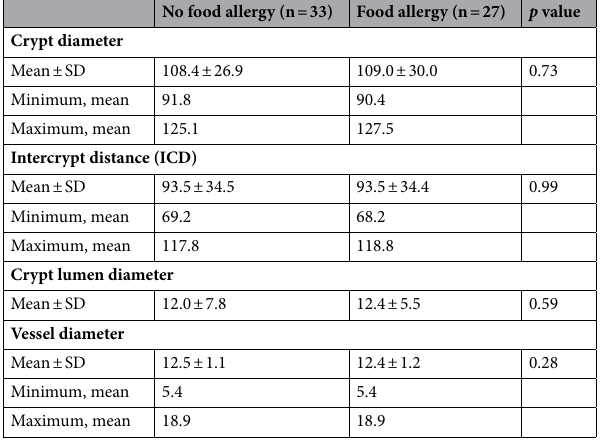
Table 4. Cryptometry and Vasculature in the colon in patient with and without Food